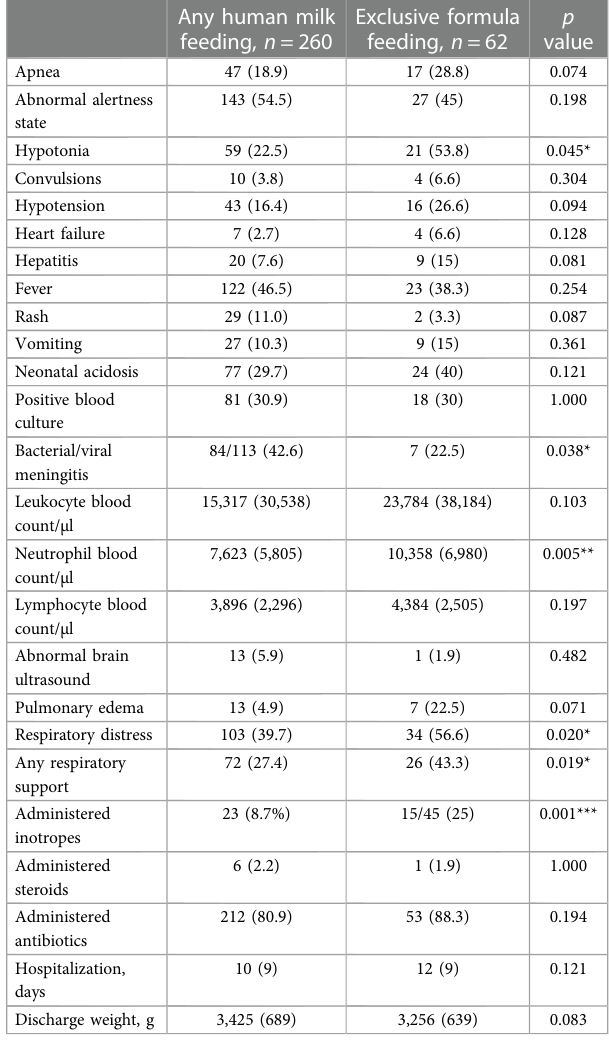
TABLE 2 Clinical or laboratory outcomes by feeding type.